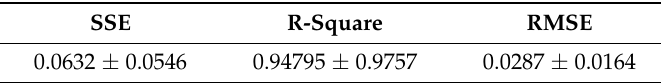
Figure 8. The original data after sorting and the curve of the fitting functions, where the points represent the original data and the curves are the fitting functions. Table 1. The evaluation for the fitting functions.